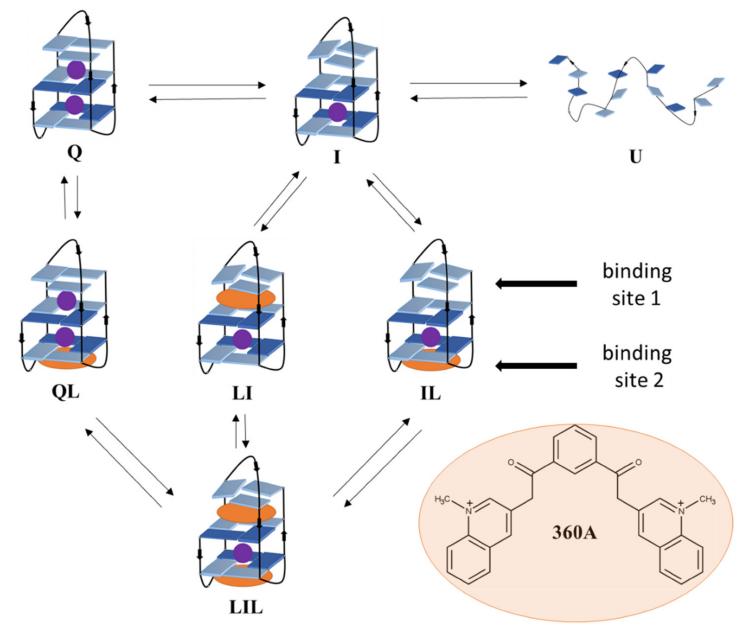
Figure 1. The simplest model mechanism that successfully describes temperature- and ligand (L = 360A) binding-induced structural conversions of 22GT. It includes folded species (Q, QL) with two specifically bound potassium ions, intermediate species (I, LI, IL, LIL) with one specifically bound potassium ion and an unfolded form (U). All the presented species are considered to be in